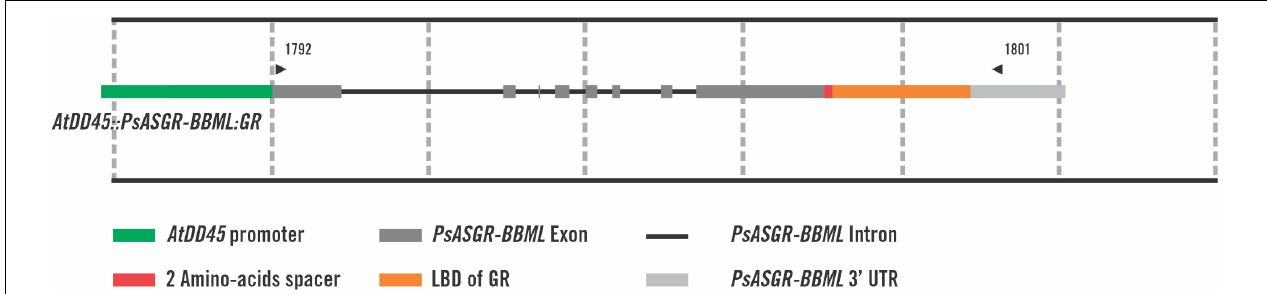
FIGURE 1 | Visual representation of the AtDD45::PsASGR-BBML:GR transgene cassette. The green rectangle denotes the DD45 promoter from Arabidopsis. The gray rectangles denote the PsASGR-BBML exons, with black lines representing introns. The red rectangle denotes a two amino acid spacer between the last amino acid of PsASGR-BBML and the ligand-binding domain (LBD) of GR, which is represented by the orange rectangle. The light gray rectangle denotes the native PsASGR-BBML 3 (cid:48) UTR. Positions of primers 1792 and 1801 are represented by small black